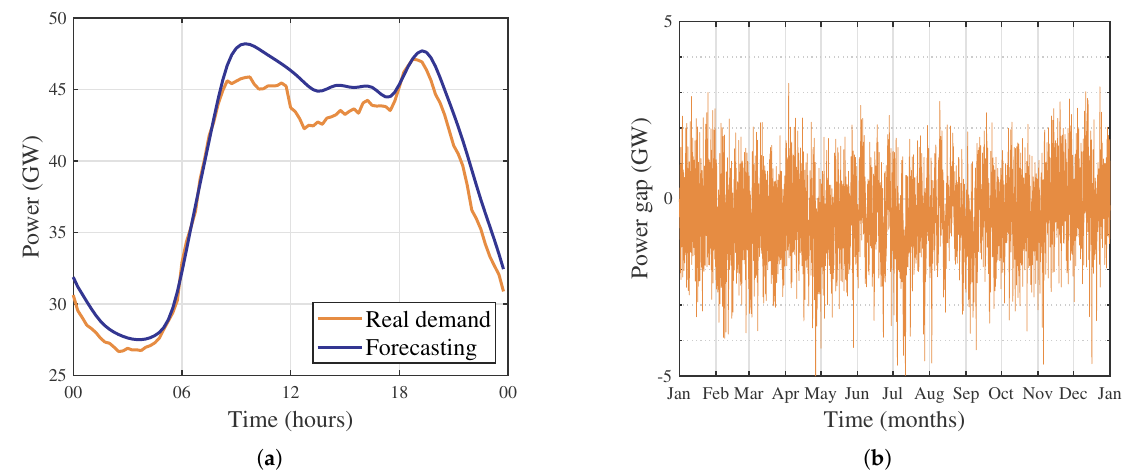
Figure 1. Discrepancy between forecasts and real demand in Italy: ( a ) hourly profile of 1 March 2019; ( b ) hourly profile from January 1st 2019 to December 31st 2019. Data from Italian transmission system operator (Terna)